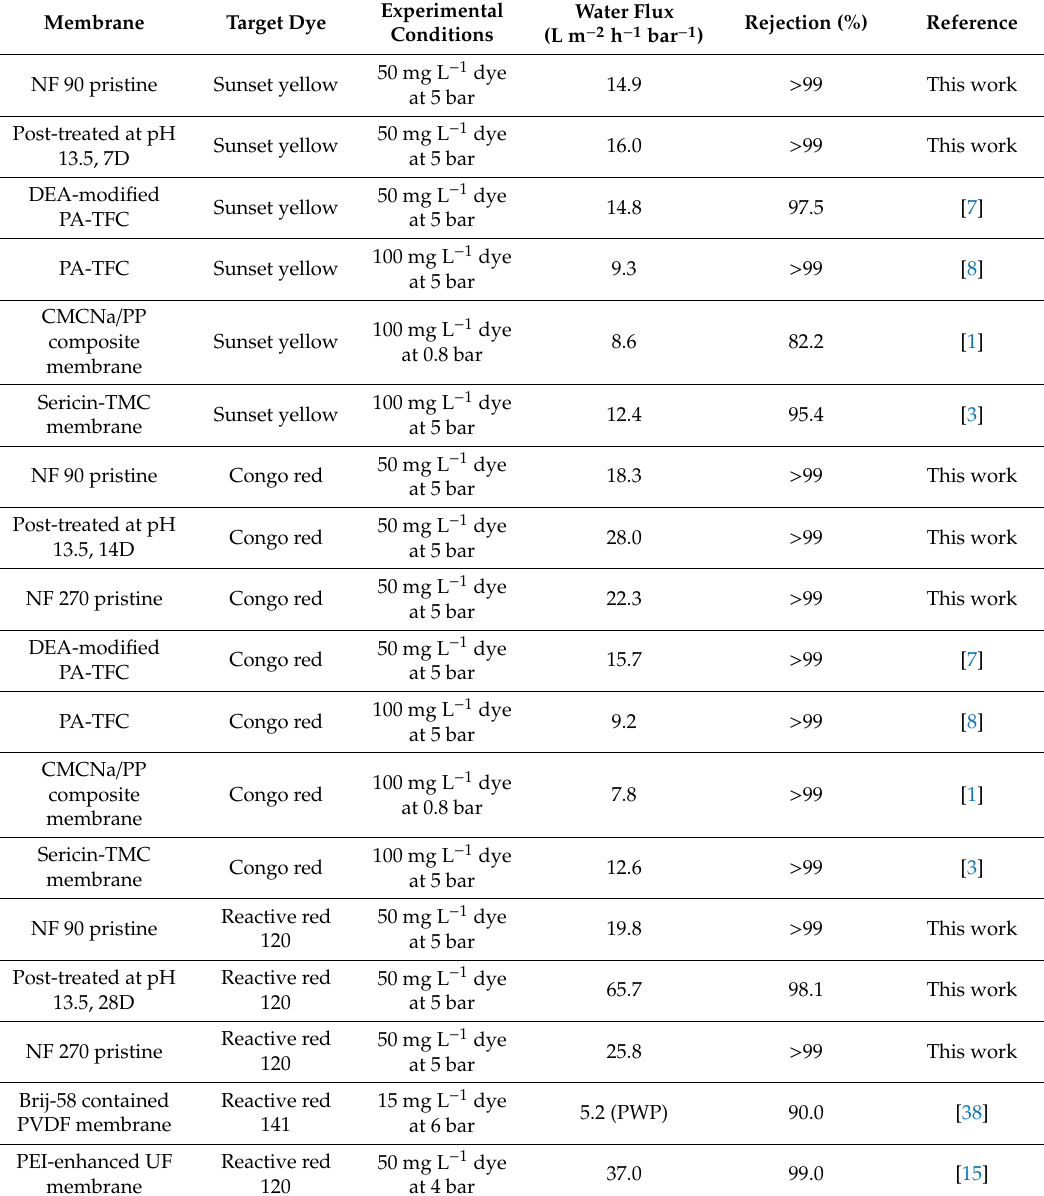
Table 3. Comparison of dye removal between previous studies and this study in terms of water flux and